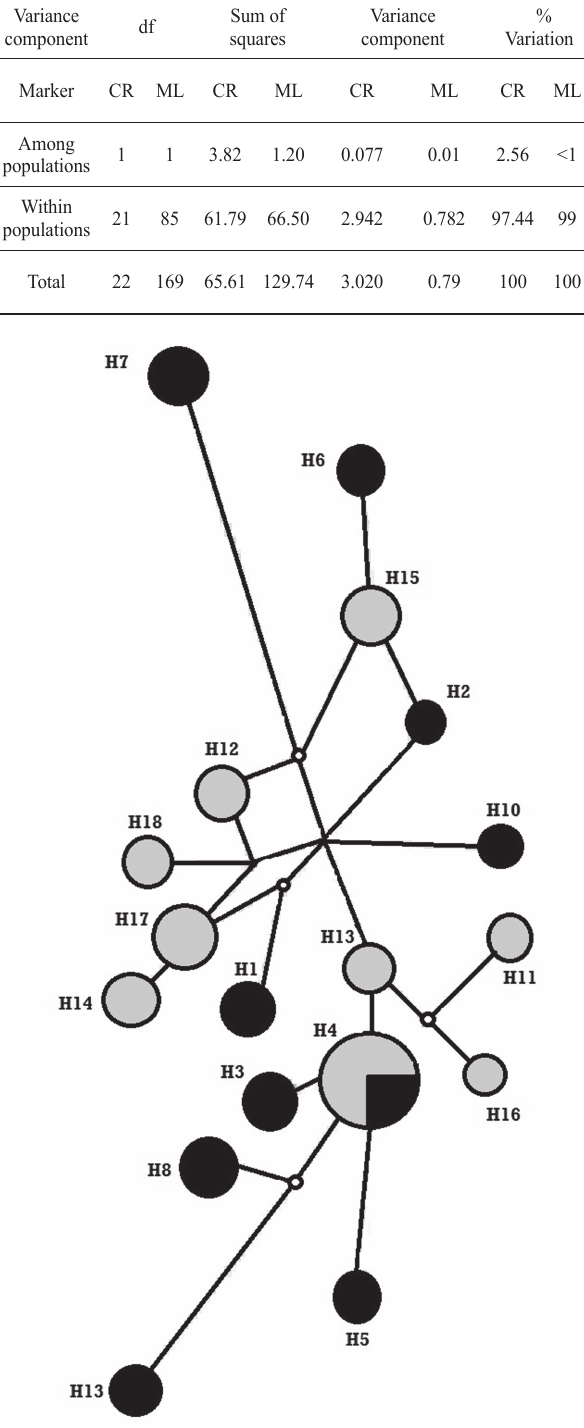
Fig. 3. The haplotype median-joining network of Pagrus pagrus for both N-CSB (Black) and S-CSB (Grey). The size of the circle is proportional to the frequency, and the distance between circles reflects the number of